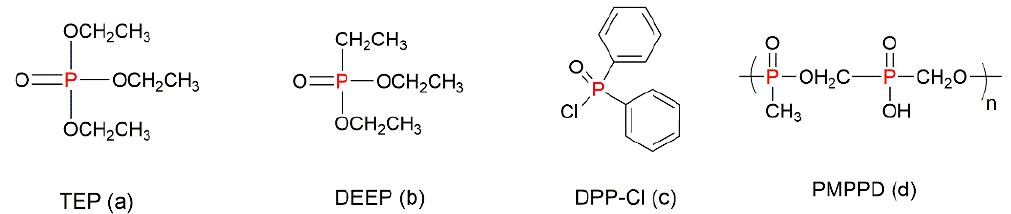
Figure 12. Chemical structures of organophosphorus additive FRs [38,80,84].